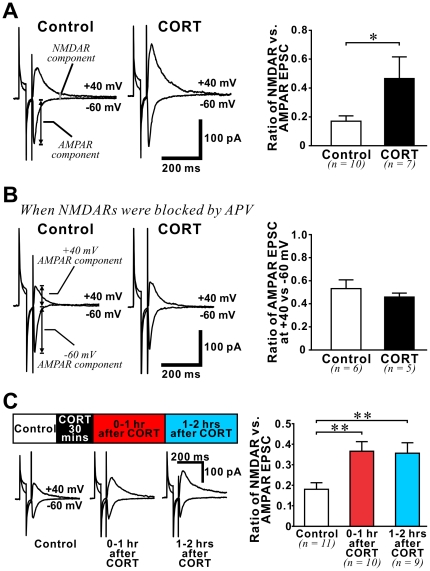
Stress level CORT increased NMDAR/AMPAR ratio of evoked EPSC in the adult hippocampus.(A) Left: Representative average traces of evoked excitatory postsynaptic currents (EPSCs) recorded from CA1 pyramidal neurons under control condition or during CORT treatment. CA1 neurons were voltage clamped at −60 mV to isolate the AMPAR component (peak of EPSC). The NMDAR component of EPSCs was measured in the same neurons while voltage-clamping them at +40 mV. EPSC amplitude at 150 ms after the stimulating artefact, when AMPAR component has returned to baseline, was used to calculate the NMDAR component. Right: histogram summarizes the ratio of NMDAR/AMPAR recorded in control and during CORT slices. CORT significantly increased the NMDAR/AMPAR ratio. * p<0.05: student's t-test. (B) CORT did not affect the ratio of EPSC amplitude recorded at +40 and −60 mV holding potential when NMDAR was blocked by APV (50 µM). (C) Left: representative average traces of evoked EPSCs recorded from CA1 pyramidal neurons in control slices and in CORT-treated slices in two time windows: 0–1 hour and 1–2 hours after CORT (depicted by a schematic time line above traces). Changes in NMDAR/AMPAR ratio caused by a 30-min CORT treatment at these time windows are summarized in a histogram (right). Note that NMDAR/AMPAR ratio is significantly increased in both post-CORT treatment time windows. ** p<0.01: post-hoc Fisher's test after ANOVA.